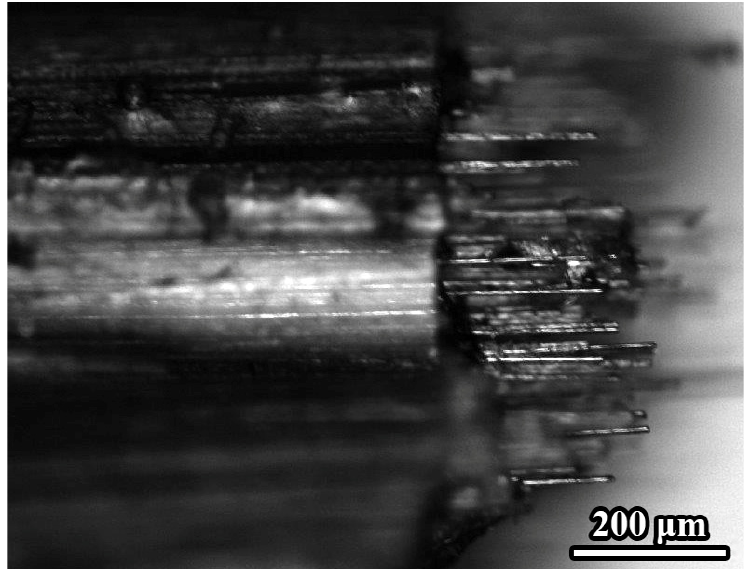
Figure 2. A side view of the fracture surface of the carbon plastic after its tensile